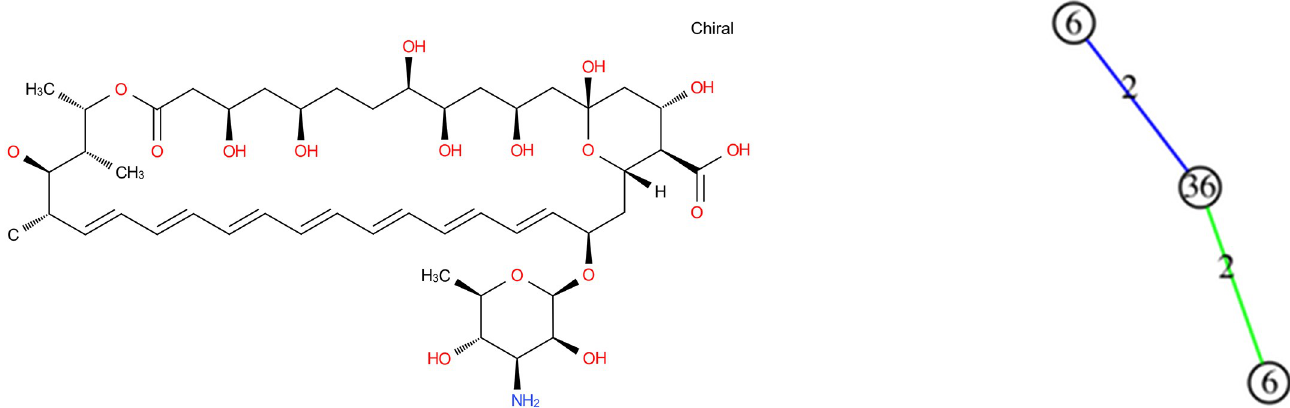
Fig 15. Amphotericin B molecular graph and its graph of cycles. According to the definition of graph of cycles, we compute the graph of cycles of the molecule Amphotericin B.